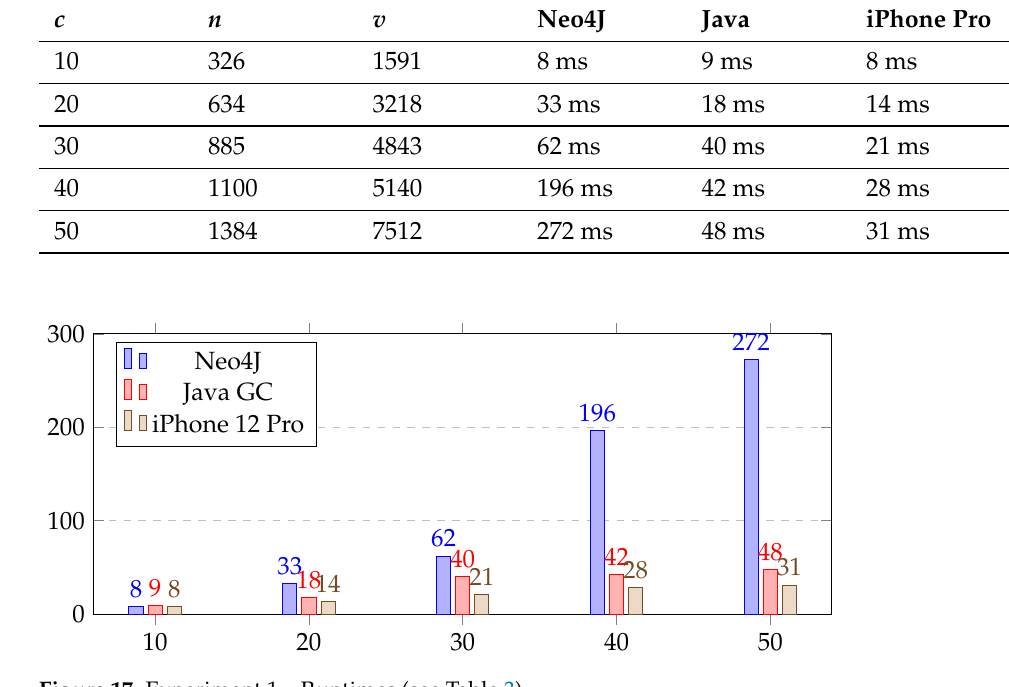
Table 3. Experiment 1—Similarity comparison of images performance on the Flickr30k dataset.